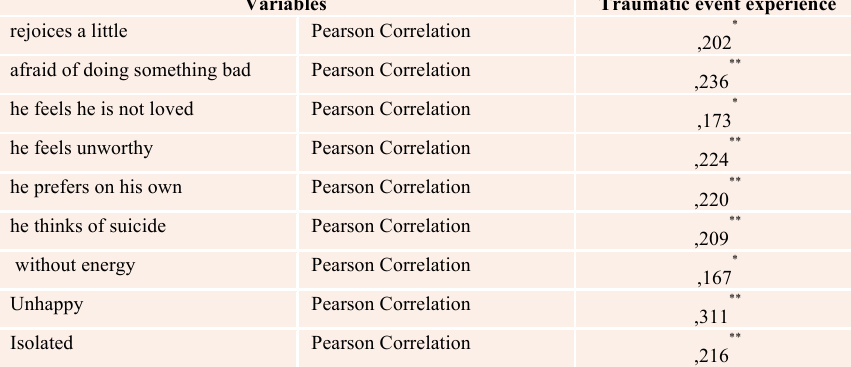
Table 1. Correlation of questions with variable traumatic event experience